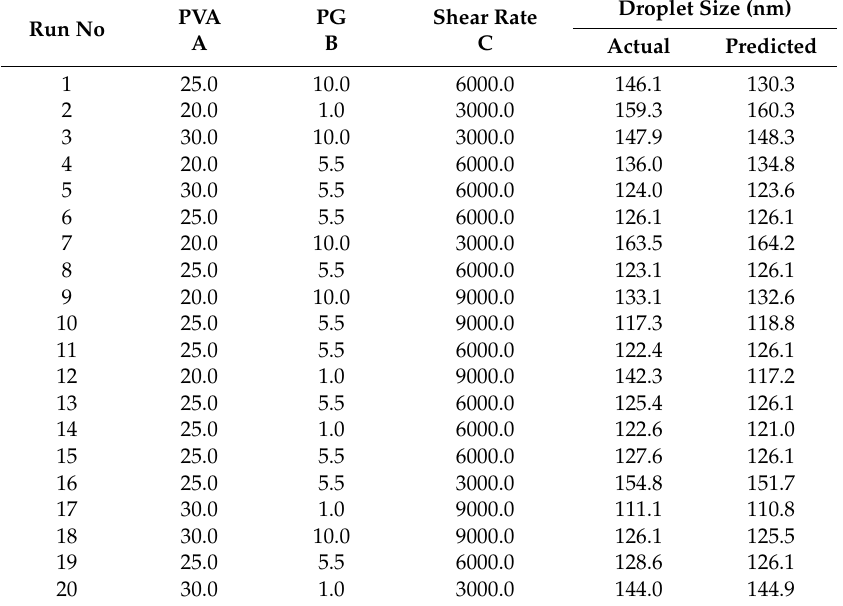
Table 2. Experimental data and the actual and predicted values of the droplet size of the nanoemulsion obtained from the RSM experimental design model.